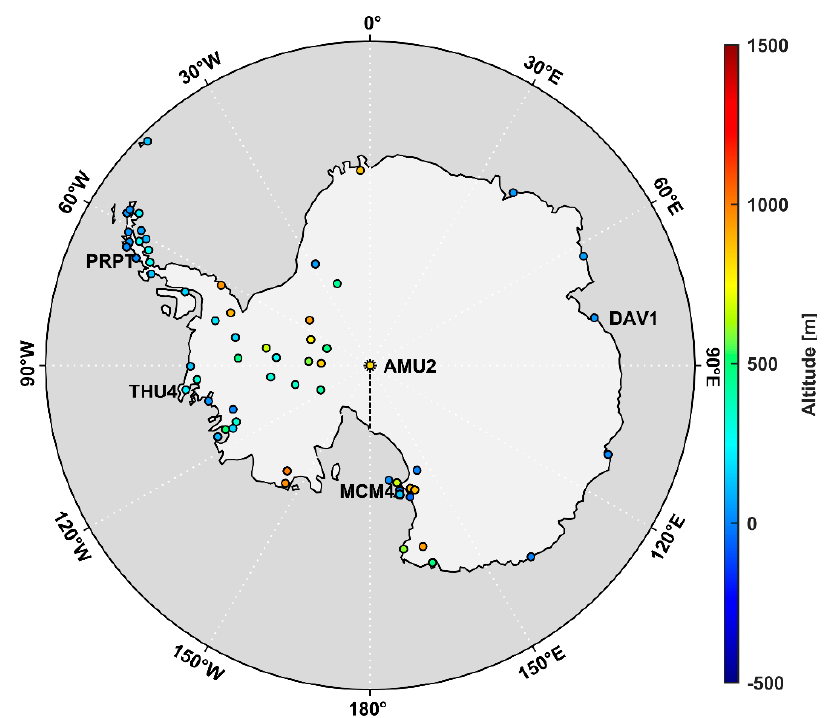
Figure 1. Distribution of experimental GNSS stations from 1 January 2018 to 23 October 2021.